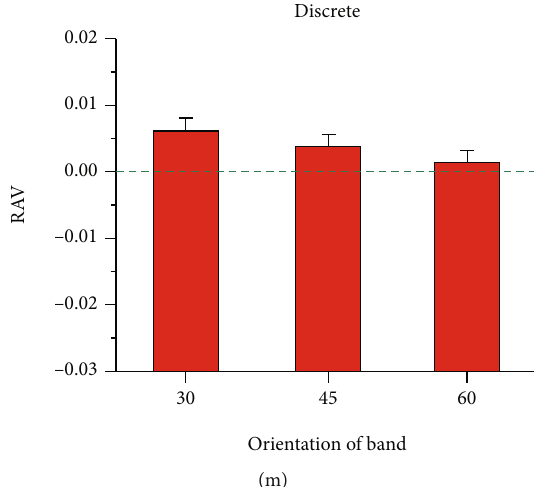
Figure 5: RAV within the bands of di ff erent orientations on hexagonal closely packed cells. (a) Schematic of hexagonal closely packed cells. (b, e, h, and k) RAV within the bands with di ff erent orientations on central cell at three FSS magnitudes under constant FSS gradient of 0.05Pa/mm. (c, f, i, and l) RAV within the bands with di ff erent orientations on central cell at three FSS magnitudes under constant FSS gradient of 0.1Pa/mm. (d, g, j, and m) RAV within the bands with di ff erent orientations on central cell at three FSS magnitudes under constant FSS gradient of